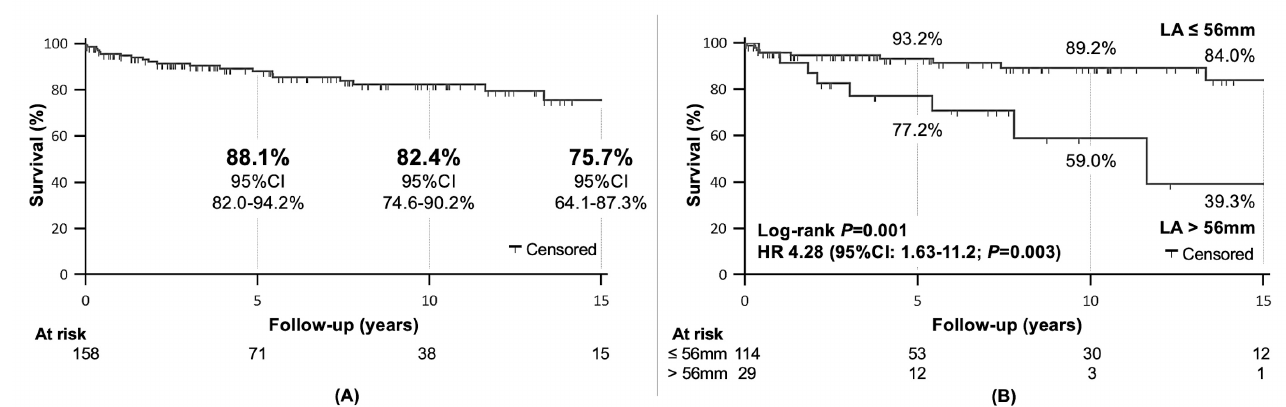
Fig. 2 - (A) Overall postoperative survival free of mitral reoperation. (B) According to left atrial (LA) diameter. CI=confidence interval; HR=hazard ratio